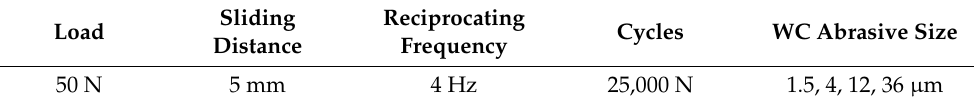
Figure 1. Schematic diagram of the friction test device. Table 2. The parameters of friction and wear